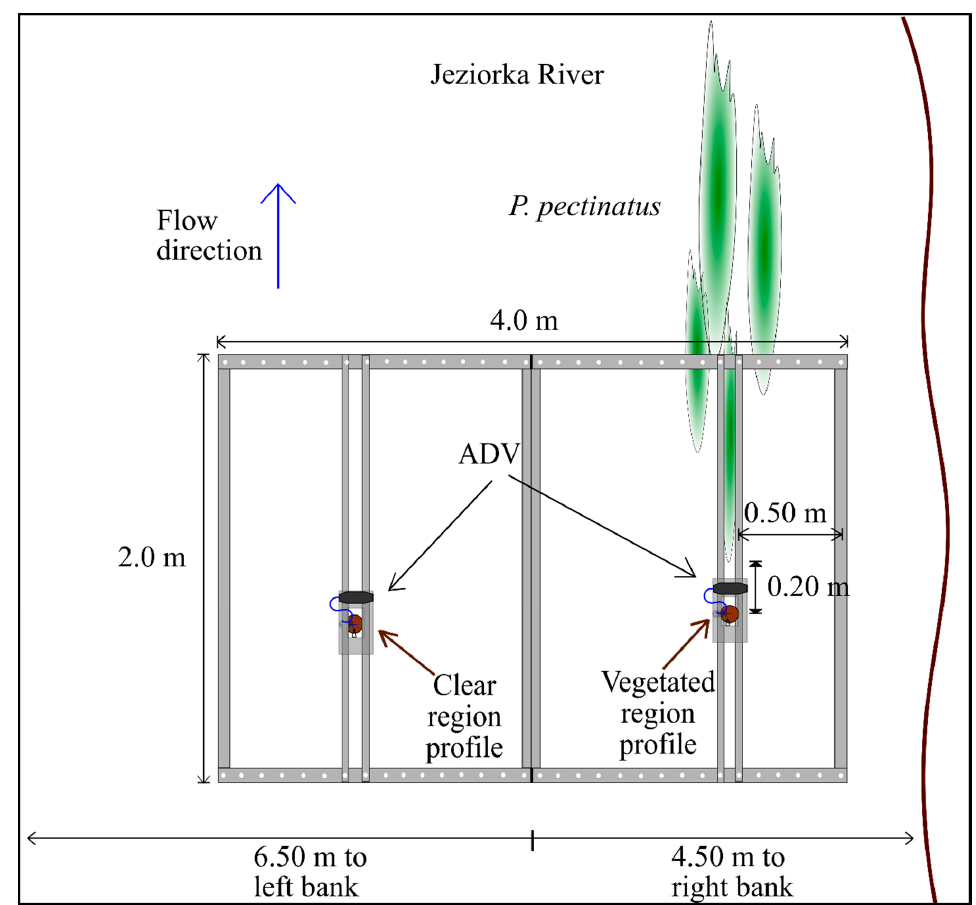
Figure 2. Arrangement of the platform with Vectrino Profilers and individuals of P. pectinatus during the experiment in the Jeziorka River (second part).